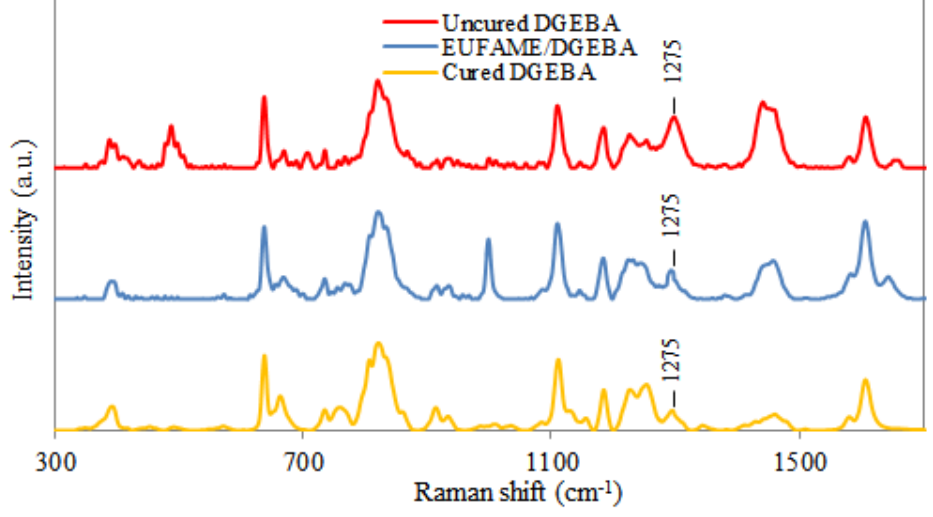
Figure 6. Raman spectra of EUFAME/DGEBA, DGEBA and uncured DGEBA.